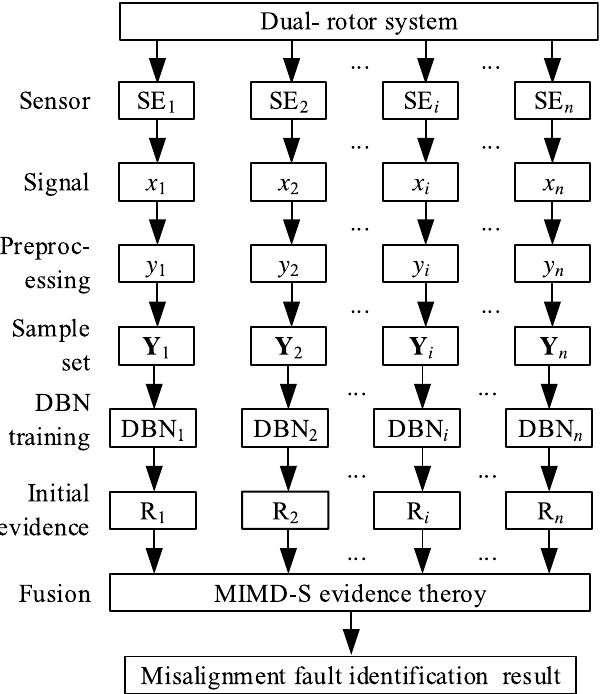
Fig. 1. The misalignment fault identi fi cation algorithm diagram based on the DBNMIND-S evidence